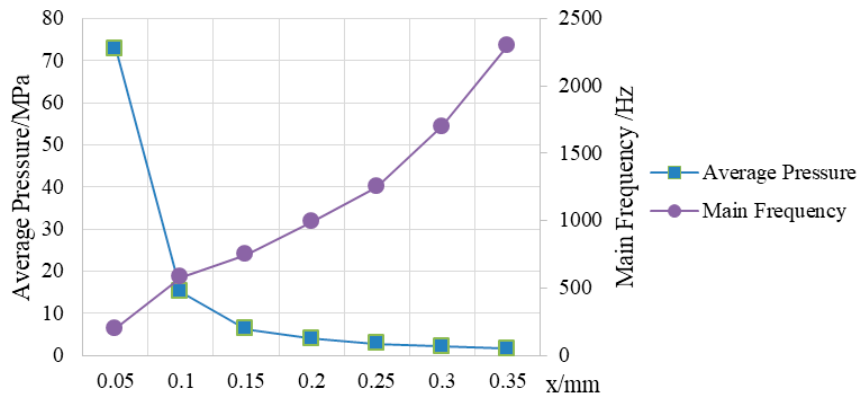
Figure 27. Pressure oscillation curve of the flapper under the influence of the main valve when the displacement of the flapper is x = 0.15 mm. ( a ) Point 1 in the time domain. ( b ) Point 1 in the frequency